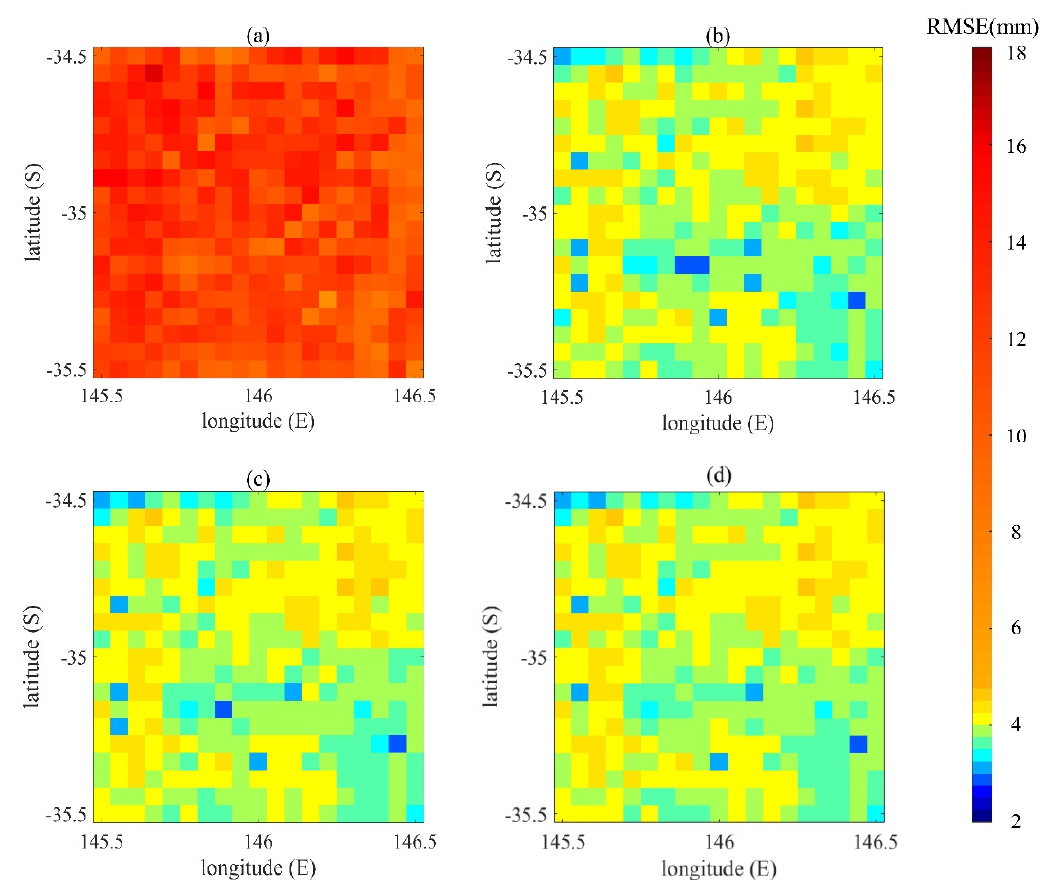
Figure 4. The root mean square error (RMSE) values between the CCI data and: ( a ) VIC simulation; the BGM method using the breeding lengths of ( b ) 24 h; ( c ) 48 h; and ( d ) 72 h.